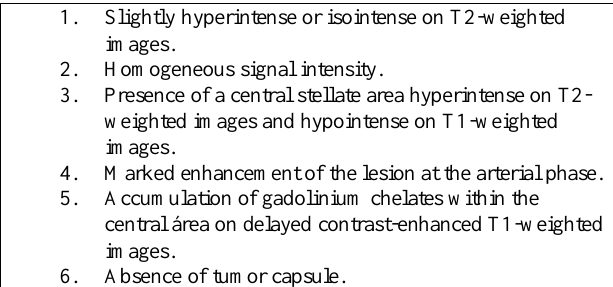
Table 1: Combination of MR Criteria Required for Diagnosis of FNH. Data from Mathieu, et al